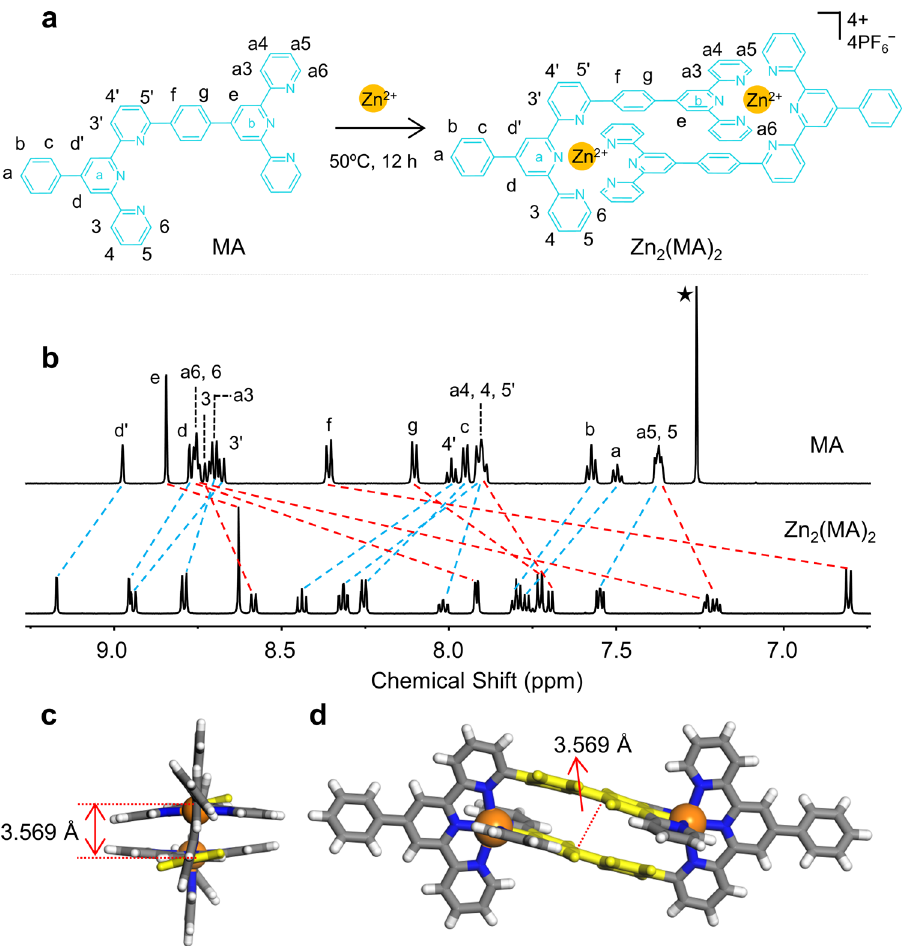
Fig. 2 The self-assembly and characterization of head-to-tail complex Zn 2 (MA) 2 . a The self-assembly of model system MA with Zn(II). b The 1 H NMR spectra (600 MHz, 300 K) of MA in CDCl 3 and complex Zn 2 (MA) 2 in CD 3 CN (3 mg/mL). c X-ray crystal structure in a side view of complex Zn 2 (MA) 2 . d X-ray crystal structure in a front view of complex Zn 2 (MA) 2 . Non-coordinated anions and solvent are omitted for clarity (C, gray or yellow; H, white; N, blue; Zn, orange).